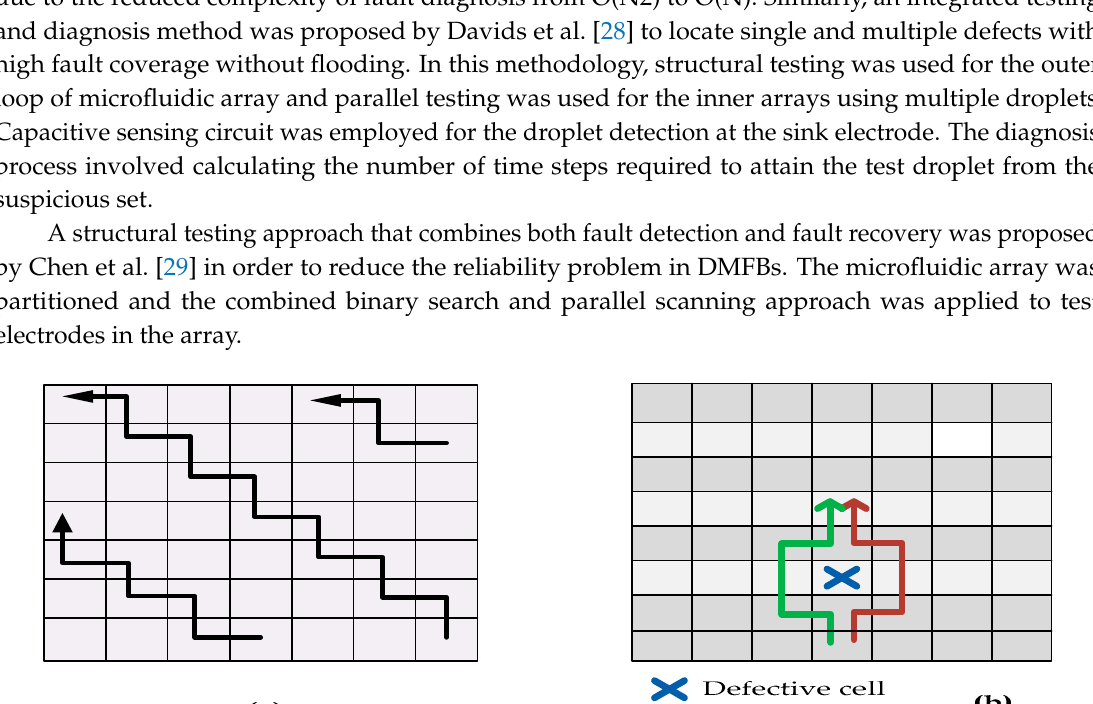
Figure 4. Structural testing ( a ) Diagonal scan-like test to detect undetectable faults; ( b ) Local detouring for high error rate [29].